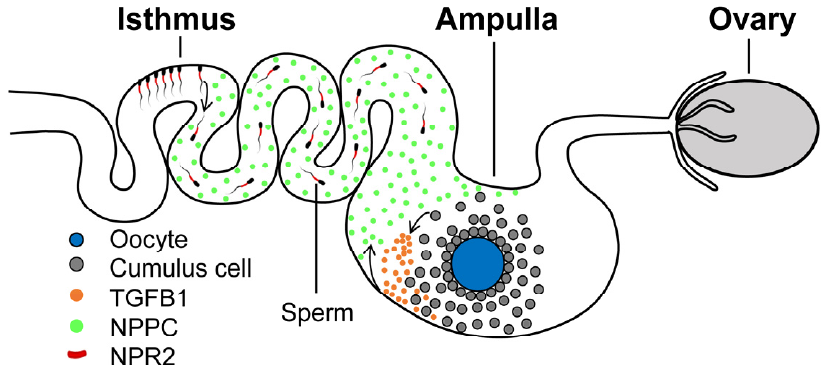
Figure 7. Model showing that mature porcine COC induced NPPC in the ampulla for sperm release. The mature porcine COCs promote the expression of NPPC in the ampullae, and then NPPC promotes sperm release from the isthmic reservoir for fertilization when ovulation occurs.